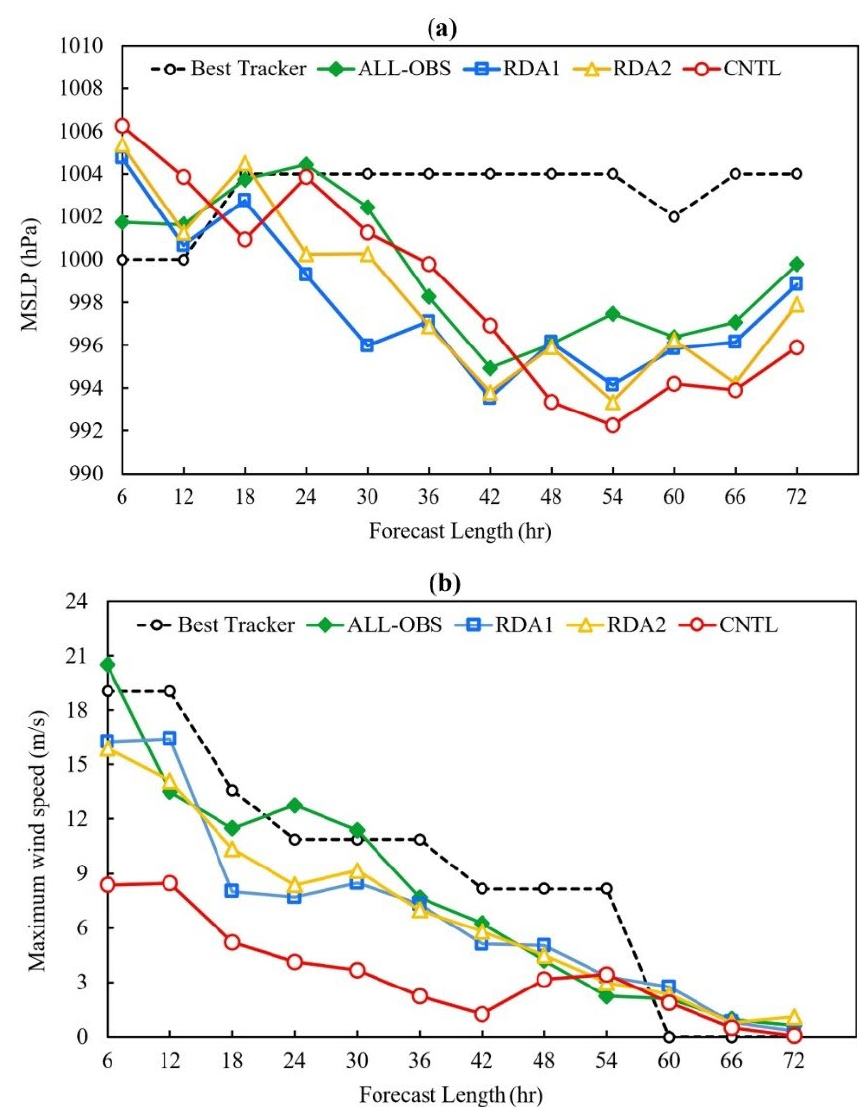
Figure 5. Variation of ( a ) mean sea level pressure (hPa) and ( b ) maximum wind (in m/s) over time (per hour) according to assimilation experiments and JMA benchmark.